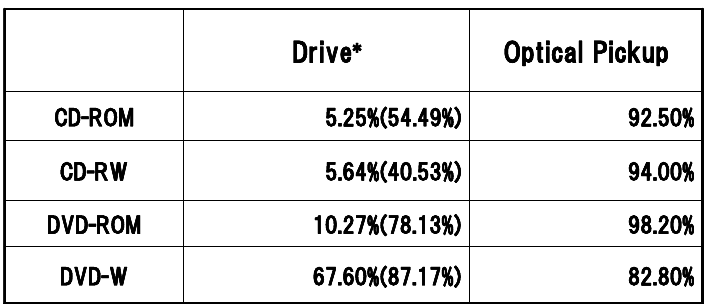
Table 1. Share of Japanese Firms in Optical Storage Industry in